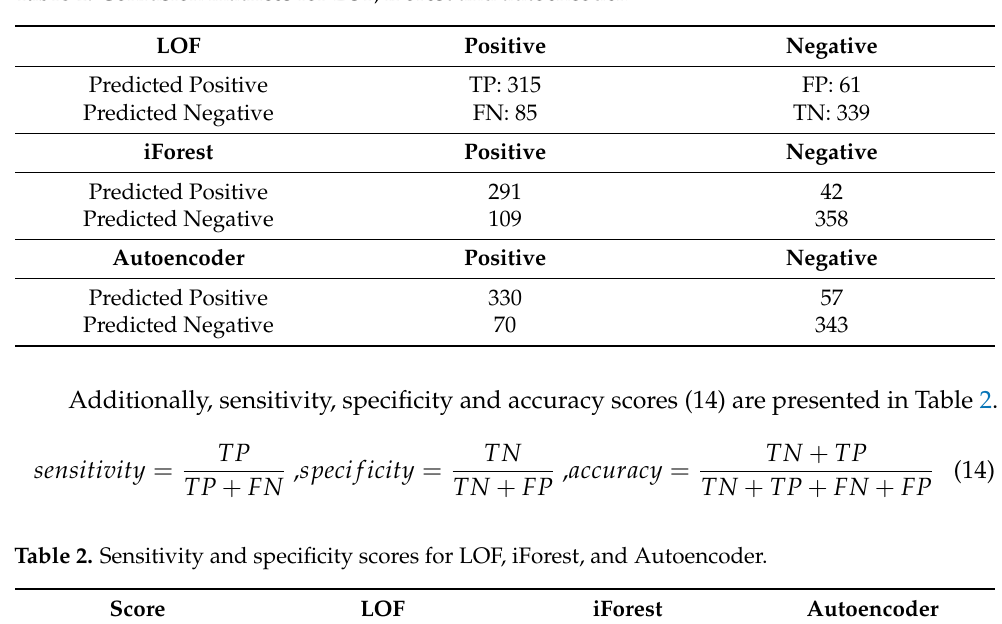
Table 1. Confusion matrices for LOF, iForest and autoencoder.